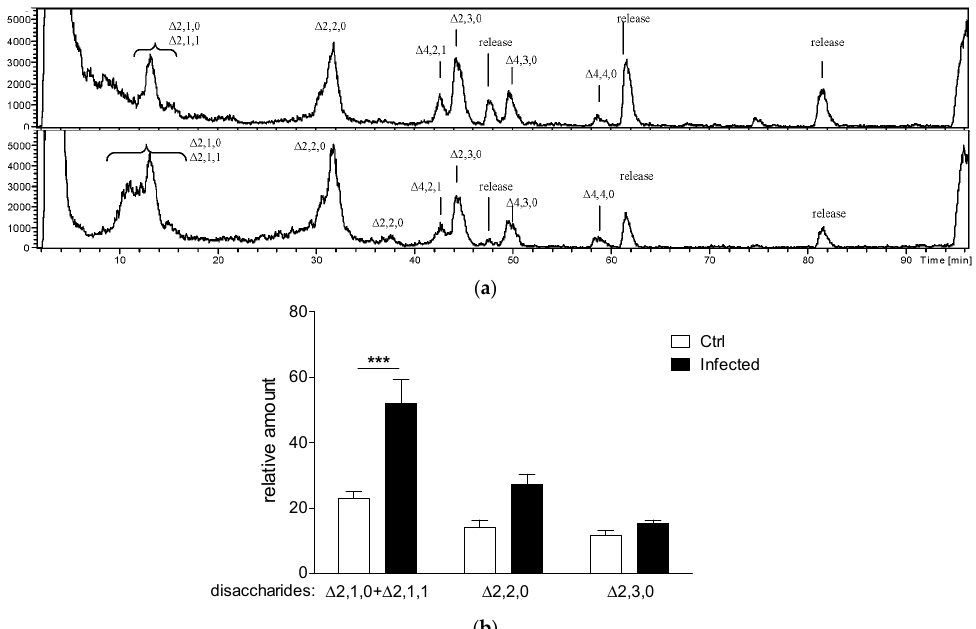
Figure 1. Disaccharide products of the digestion of heparin/HS from murine lungs after chronic P. aeruginosa infection. C57Bl/6NcrlBR mice were intratracheally injected with 1–2 × 10 6 colony forming units (CFUs) of P. aeruginosa isolate AA43 embedded in agar-beads (Infected) or with sterile agar-beads (Ctrl). After 28 days, lungs were perfused, recovered, homogenized and separated into pellets and supernatants. After removal of proteins, lipids and DNA, the presence of GAGs was verified by NMR. Samples were digested with a cocktail of heparin lyases to selectively degrade heparin/HS and recovered digestion products were desalted and finally analyzed by HPLC-MS. ( a ) Base Peak Chromatogram of digestion products from the pellet of one Ctrl uninfected ( upper panel) and one infected ( lower panel) lung homogenate from C57Bl/6NcrlBR mice. The unsaturated bond of the terminal uronic acid is indicated by Δ , and the number of monomers, the number of sulfates and the number of acetyls are reported; ( b ) The graph shows the amount of each disaccharide species detected in the whole lung of an infected and an uninfected Ctrl mouse; 100% is considered the sum of peak areas of one whole lung from infected mouse lungs containing the highest amount of disaccharides. The data are pooled from at least two independent experiments ( n = 6–15). Data are the mean ± standard error of the mean (SEM) of at least three samples per type which have been processed independently. Statistical significance is indicated: *** p < 0.001. Table 1. Structural characteristics of synthesized HS competitors originating from PMH (MW 20 kDa, %NAc 15).